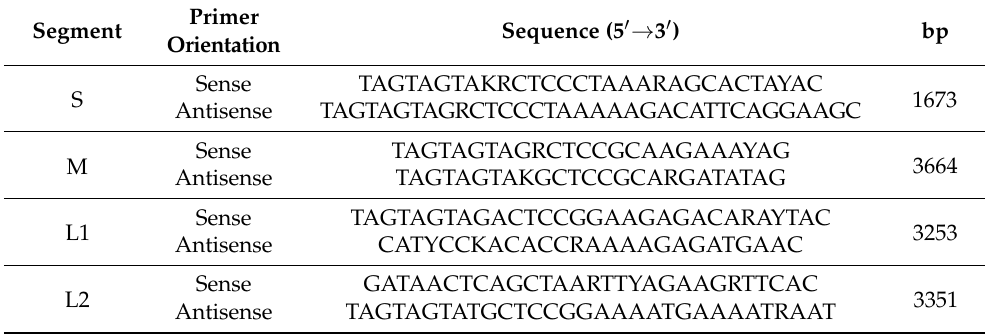
Table 1. Primers used for targetted amplification of the complete genome of